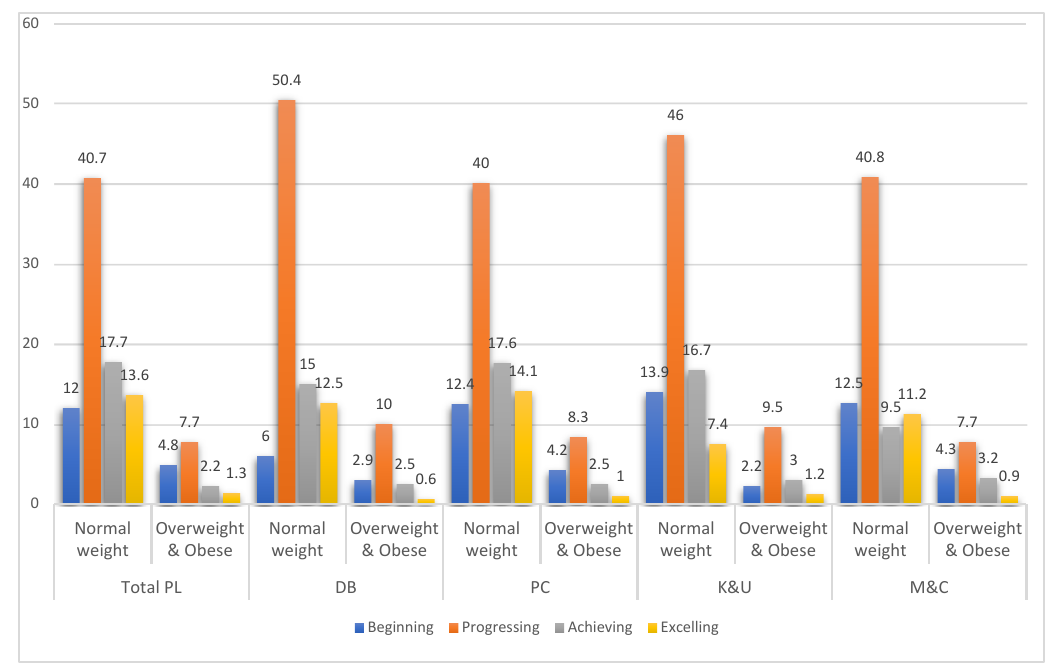
Figure 3. The number of children among CAPL-2 total and interpretive categories stratified by weight status. Table 3. Correlations between physical literacy domain scores in normal weight